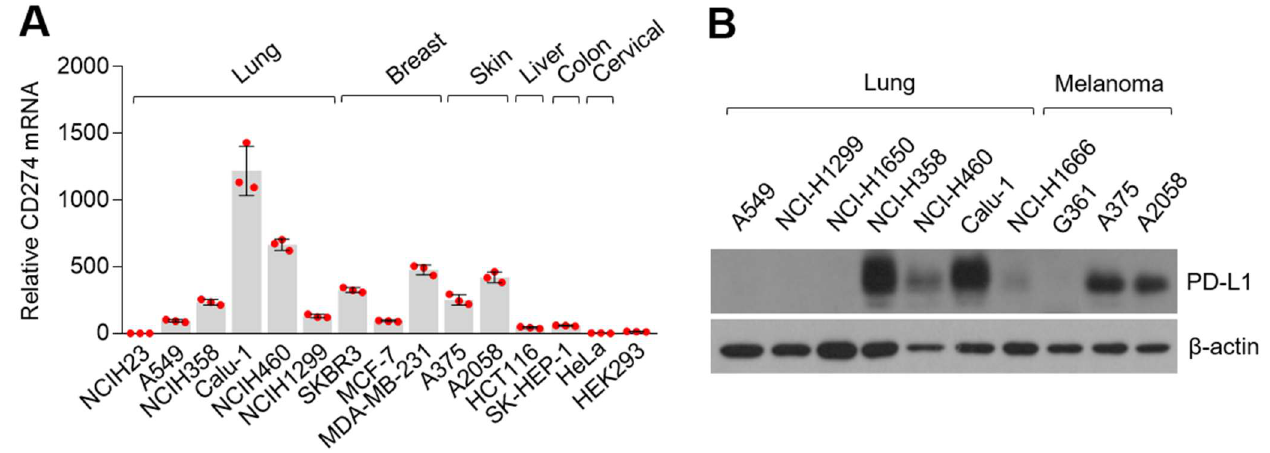
Figure 1. CD274 and its translated protein PD-L1 expression in various cancer cells. ( A ) CD274 mRNA expression in cultured cancer cell lines. CD274 mRNA levels were measured by using quantitative real-time polymerase chain reaction (qRT-PCR) and expression levels were normalized to the human 36B4 gene. The values represent the mean ± SD. Experiments were performed in triplicates. Red dot indicates the value of the individual sample. ( B ) PD-L1 proteins in seven lung cancer and three melanoma cells were measured by using western blotting.